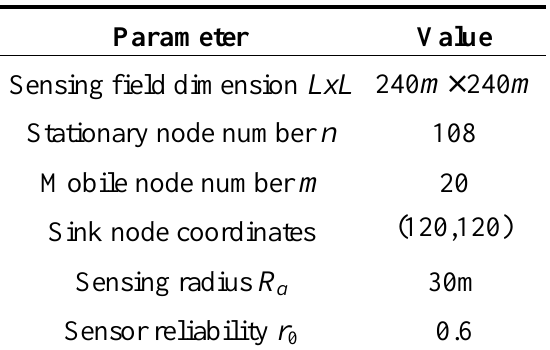
Table 1. Fundamental parameters of WSN.